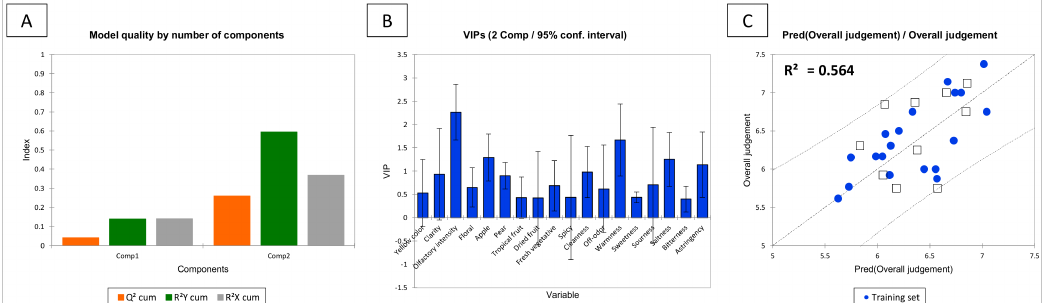
Figure 6. Summary of the partial least square regression for the overall quality judgment over the sensory descriptors. ( A ) Histogram of model quality by the number of components, Q2, R 2 Y, and R 2 X indexes; ( B ) VIPs calculated at two components for all the sensory variables; ( C ) observed values vs. predicted values of overall quality